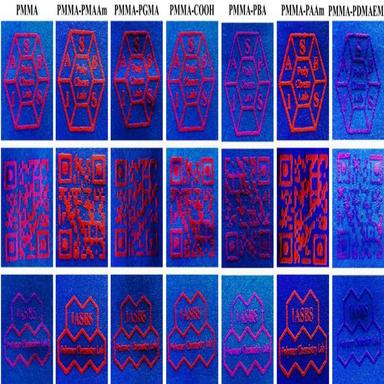
Printing of optical security tags using of photoluminescent solid inks.